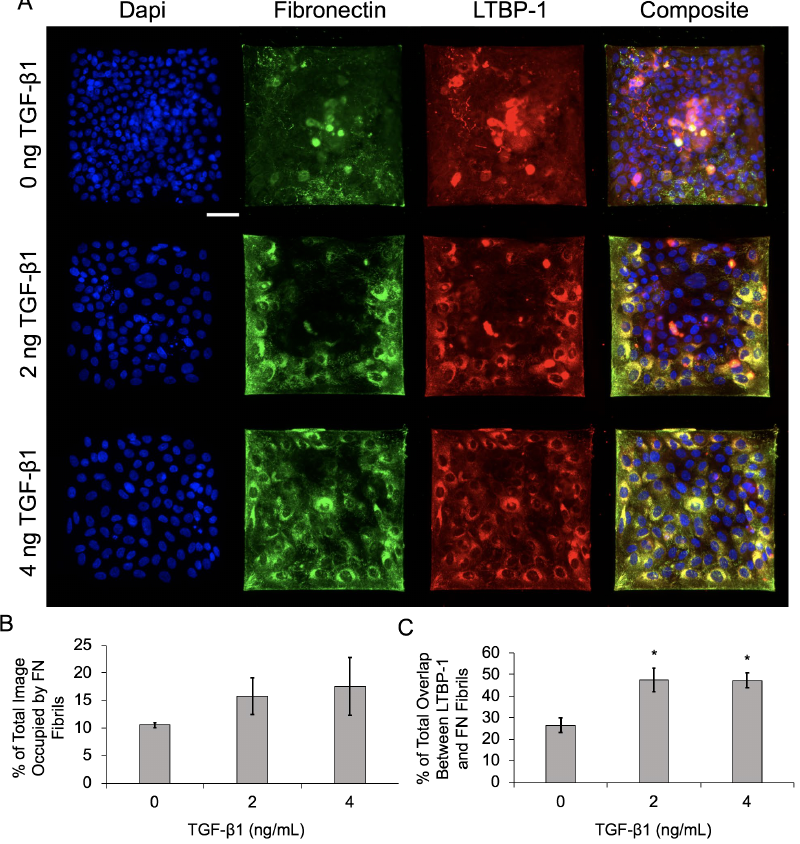
Figure 4. Increasing TGF- β 1 concentration upregulates FN fibril assembly and LTBP-1 colocalization with FN fibrils in MCF10As on laminin islands. ( A ) Immunofluorescence images of MCF10As